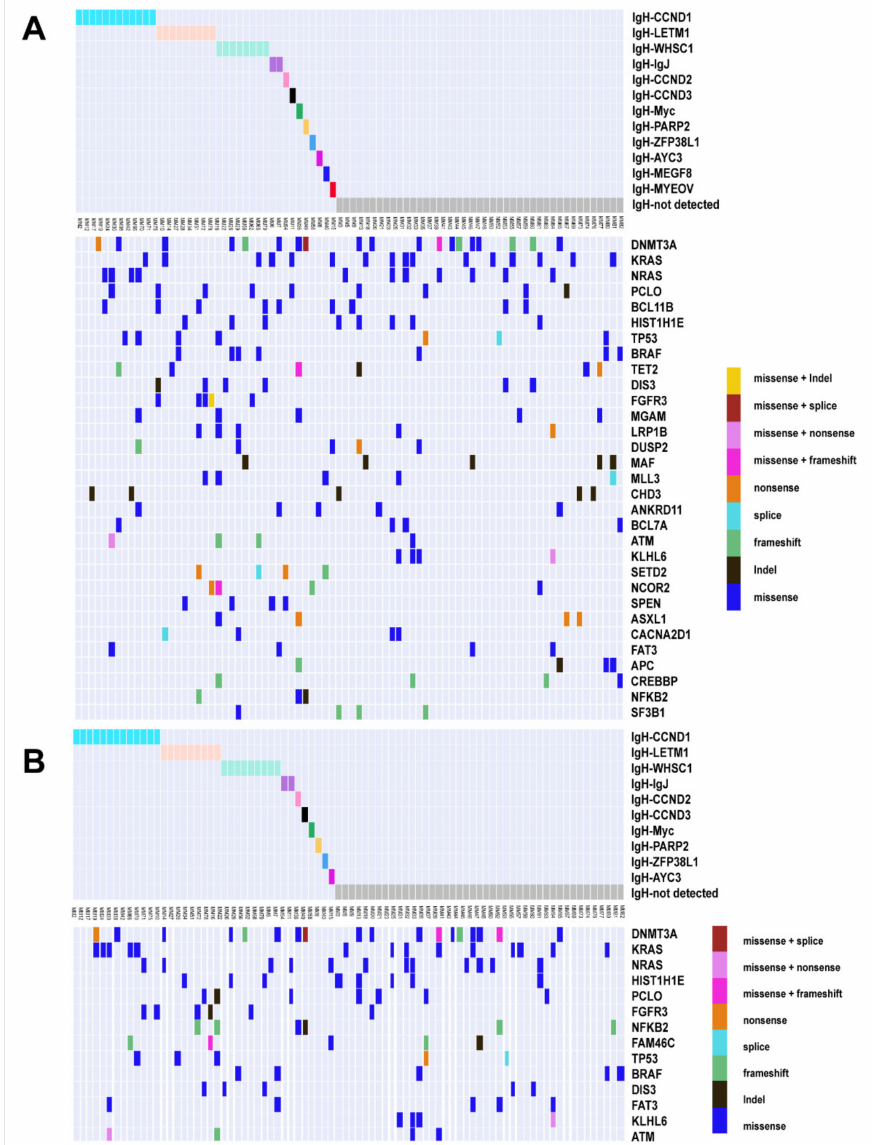
Figure 3. Genomic landscape under different IgH translocations. Somatic mutation profiles of NDMM patients grouping by IgH translocations. Different colors represent different IgH translocations and mutation types. ( A ) ctDNA; ( B )